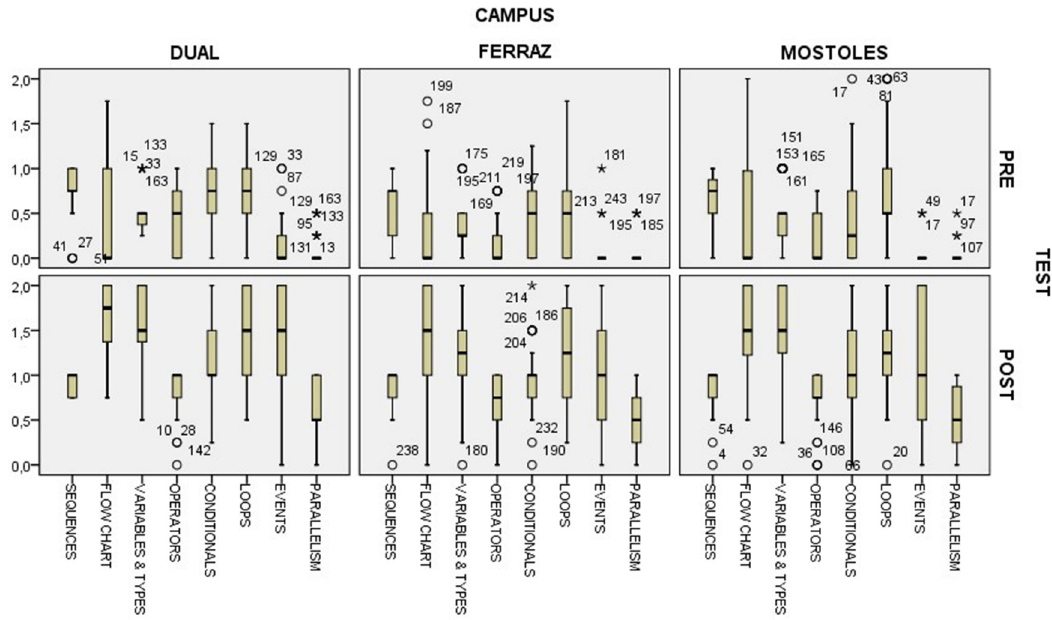
Figure 6. Boxplots of programming concepts from pre- and post-tests divided into three groups. Notice that * and ◦ are outliers in the distribution.